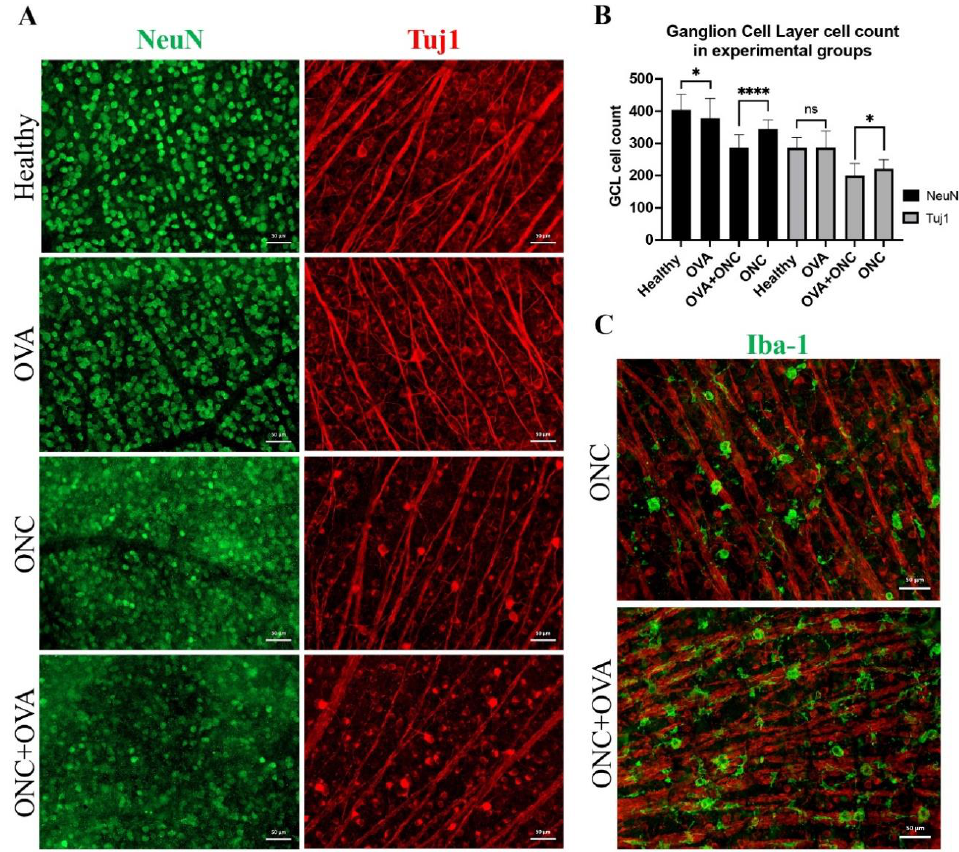
Figure 3. Immunofluorescence staining of whole mounted retinas. ( A ) NeuN- and Tuj1-positive cells in the GCL of whole mounted retinas. Scale bar: 50 µ m. ( B ) Statistical analysis of GCL cell count, ns: not significant, *: p < 0.03; ****: p < 0.0001; Welch’s t test. ( C ) Iba-1 (green) cell infiltration merged with Tuj1 (red). Scale bar: 50 µ